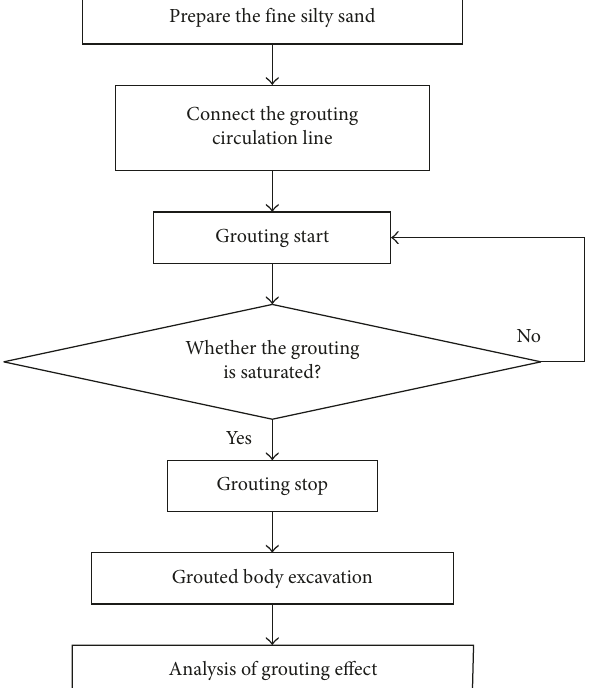
Figure 4: Flow chart of the grouting experiment.